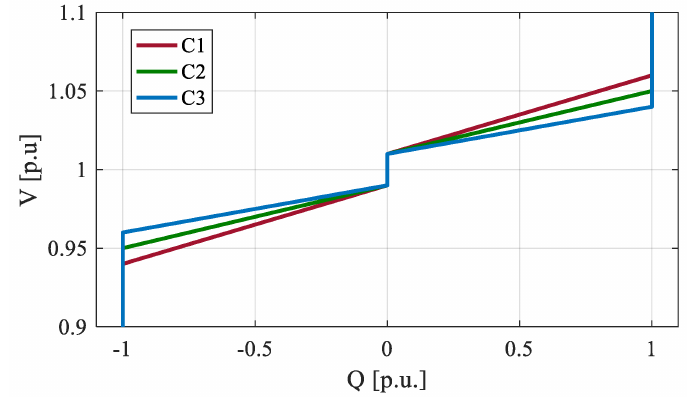
Figure 13. Local control: volt–var law set-up for